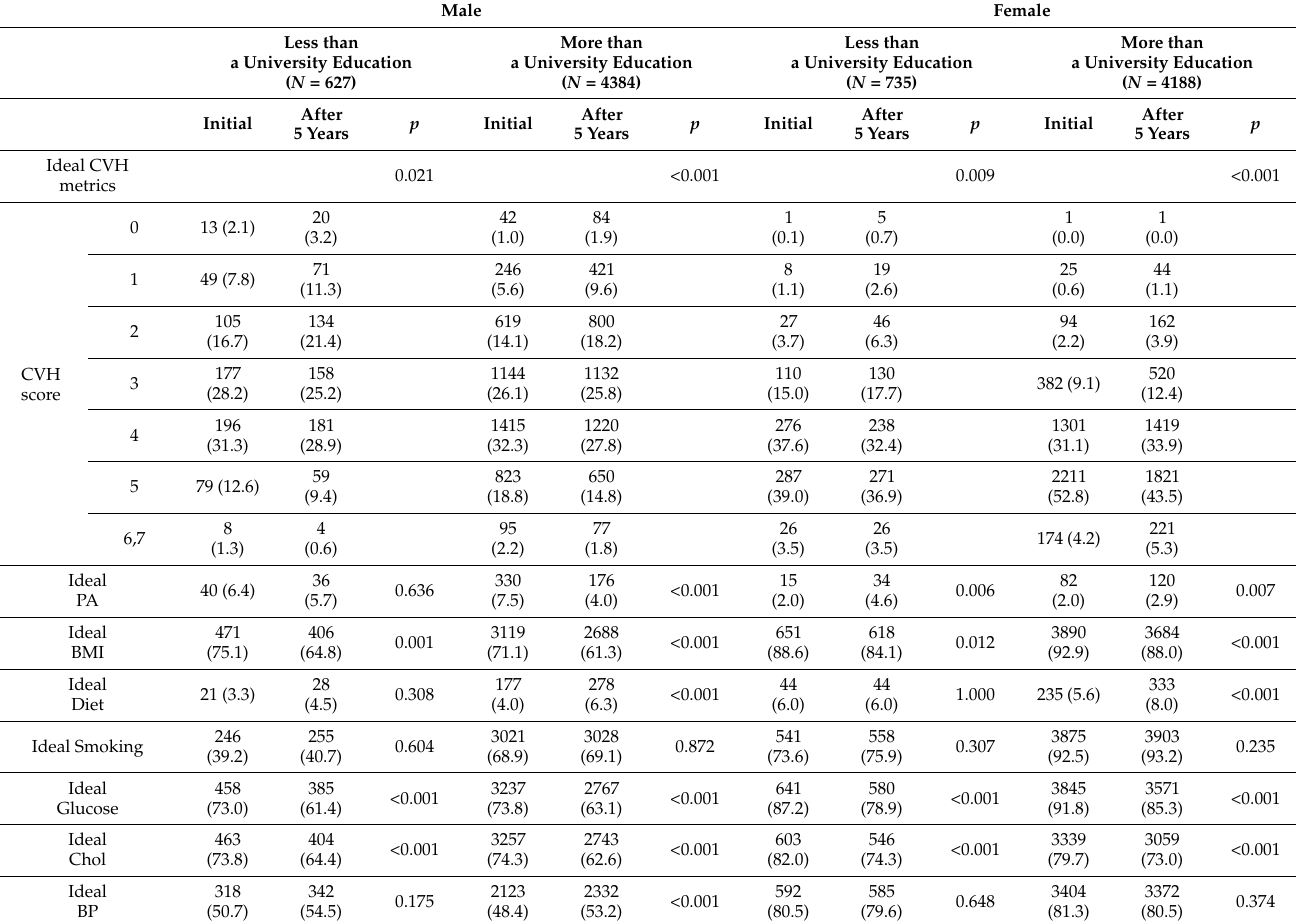
Table 3. Differences in ideal cardiovascular health metrics among the participants divided by education level after 5 years.